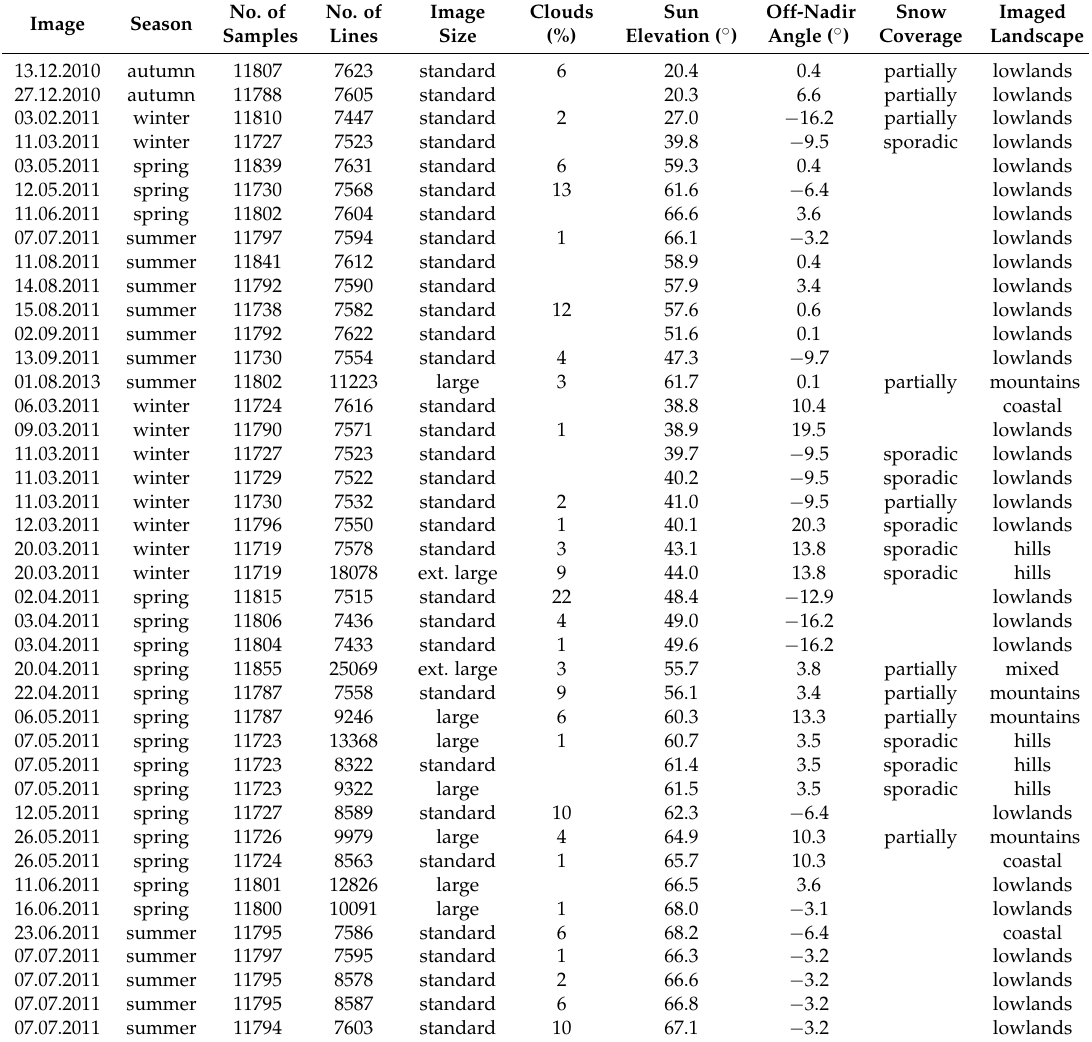
Table 1. Selected characteristics and metadata parameters for 41 RapidEye level 1B images. Images are referenced by dates.